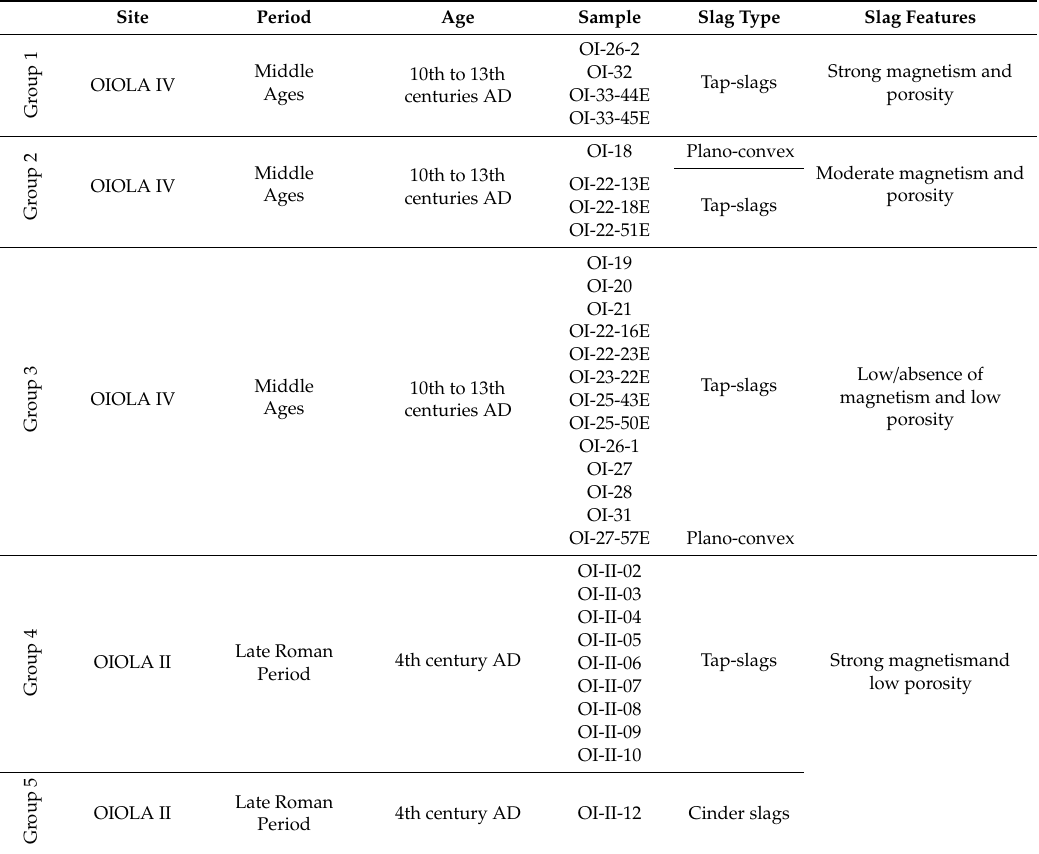
Table 1. Studied smelting slags indicating the age of samples and macroscopic features. Site